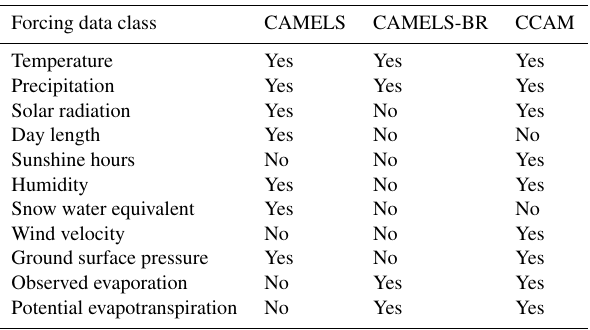
Table 2. Summary of forcing variables provided in CAMELS, CAMELS-BR, and